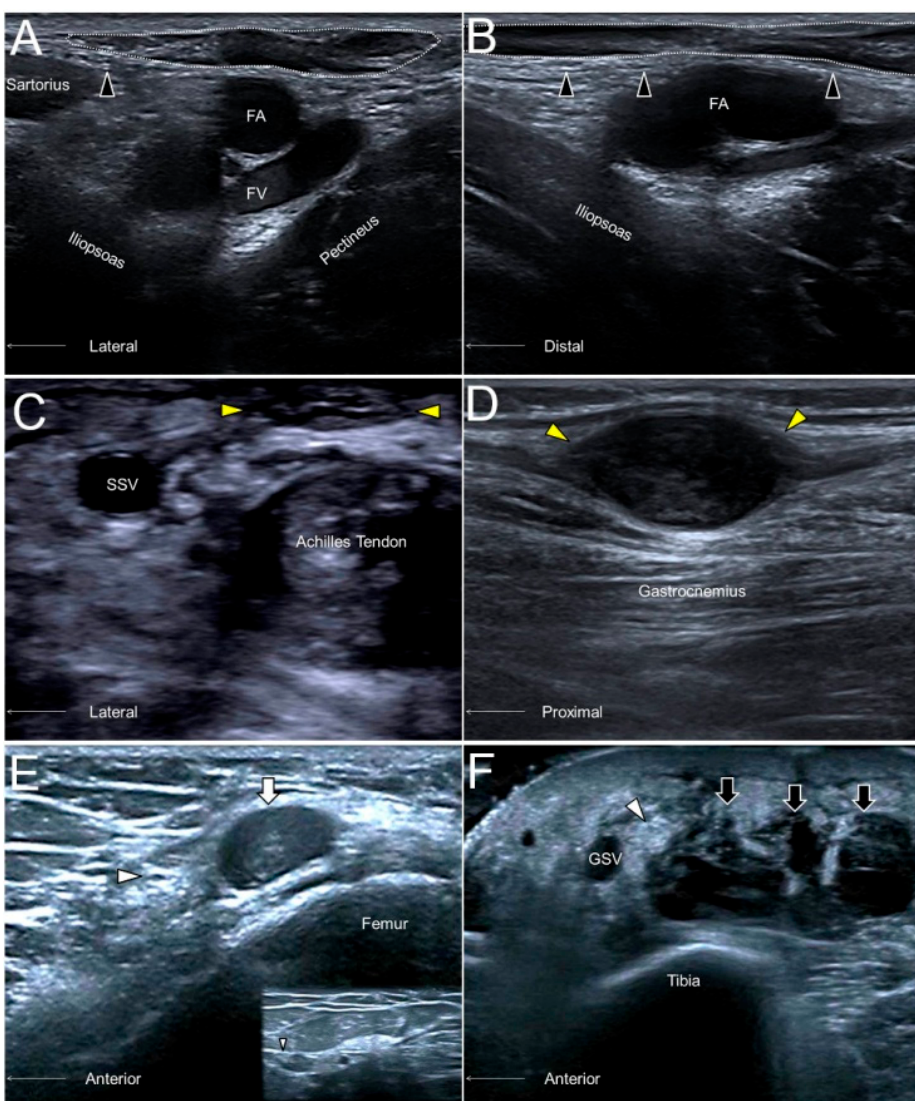
Figure 10. The short- (A) and long- (B) axes imaging of the anterior femoral cutaneous nerve (black arrowhead) compressed by an inguinal lymph node (dotted circle). A sural nerve (yellow arrowhead) neuroma in a male following Achilles tendon repair (C) . A sural nerve schwannoma in a female with chronic calf pain (D) . A swollen segment (white arrowhead) and a relatively normal portion (smaller white arrowhead) of the saphenous nerve adjacent to a hematoma (white arrow) of the distal femur (E) . A thickened saphenous nerve (white arrowhead) next to serosanguinous fluid ( black arrow ) in a female with a degloving injury of the leg (F) . FA, femoral artery; FV, femoral vein; SSV, small saphenous vein; great saphenous vein.